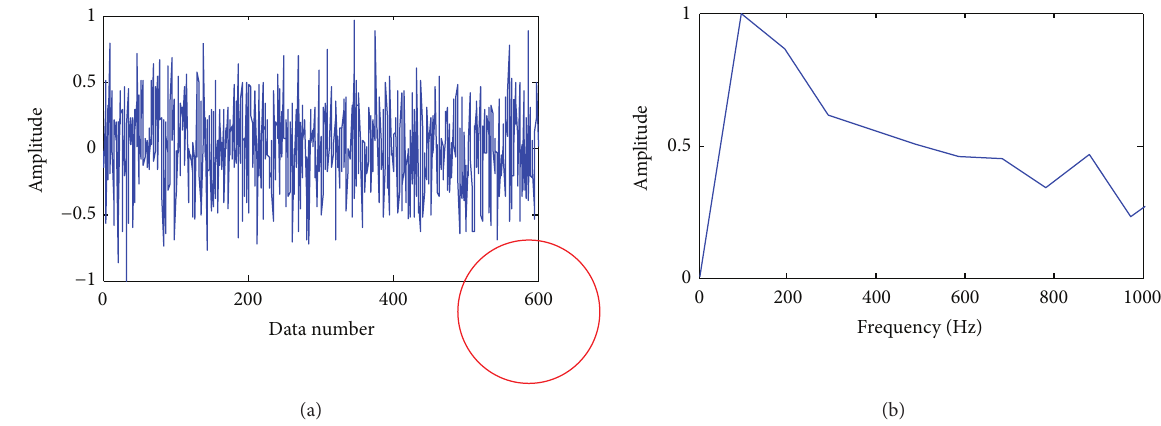
Figure 6: (a) Random sampling and (b) envelope spectrum of the original signals with 600